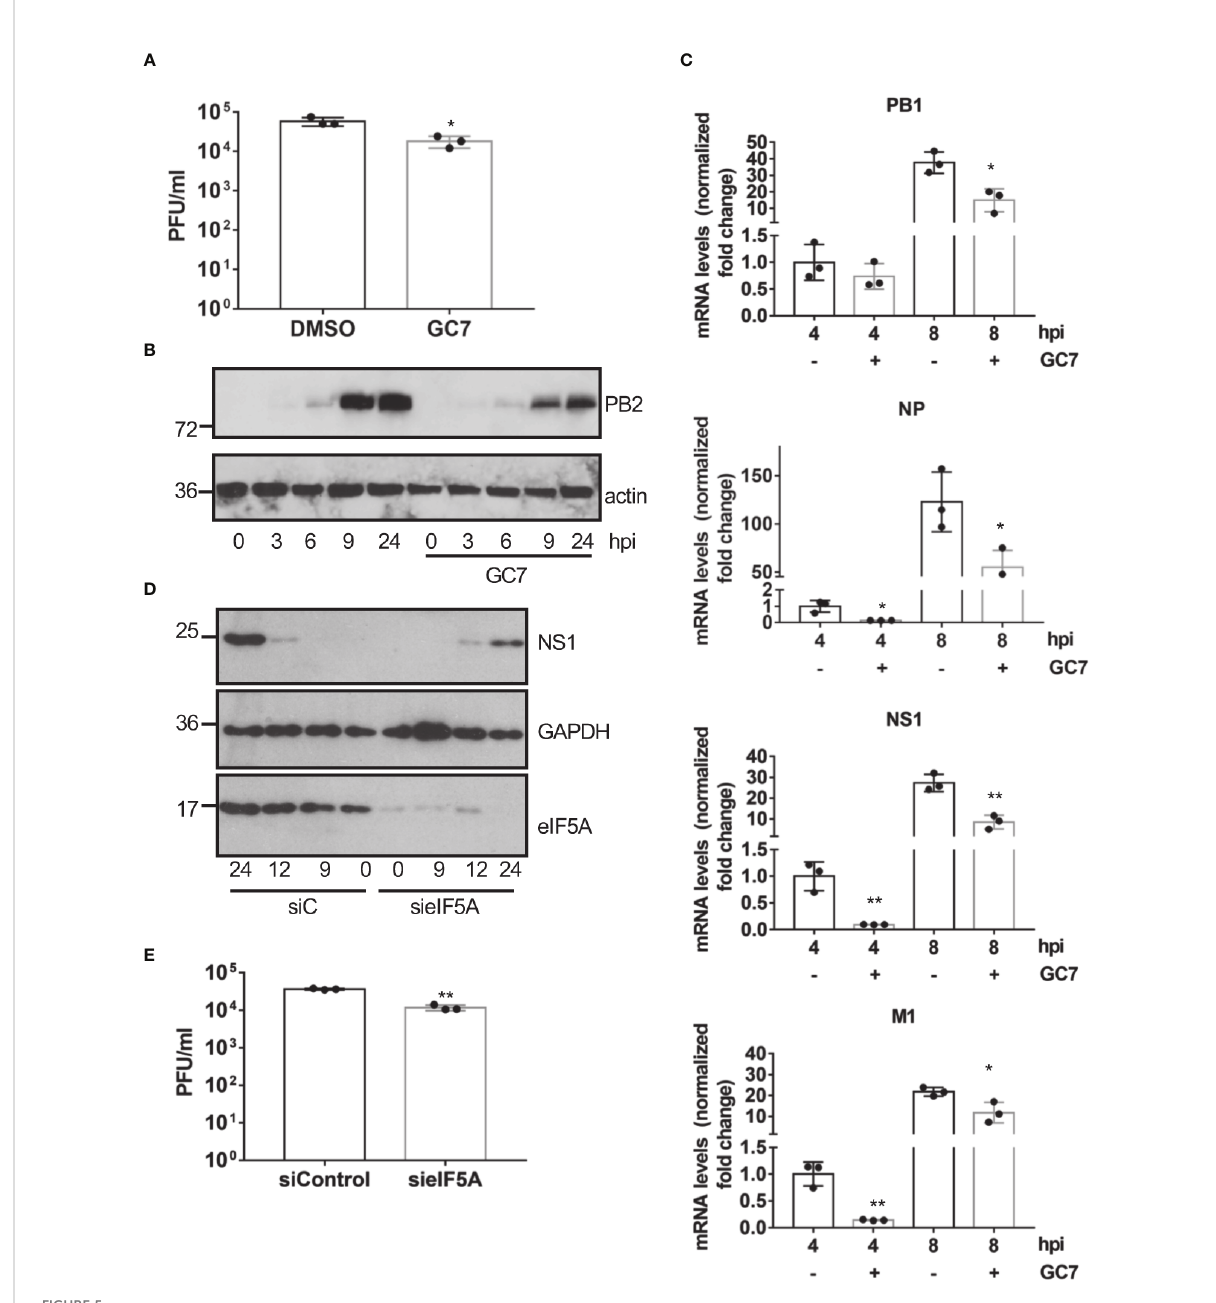
FIGURE 5 Effect of eIF5A activation on in fl uenza virus replication. (A) , Effect of hypusine inhibition on IAV virus replication. Data represent the mean and error bars of three biological replicates. Statistical analysis was assessed by a Student ’ s t-test. *, P<0.05. (B) , Consequences of GC7 treatment on IAV protein synthesis. (C) , Consequences of hypusine inhibition on viral gene transcription at the indicated times after IAV infection. Data represent the mean and error bars of three biological replicates. Statistical analysis was assessed by a Student ’ s t-test. *, P<0.05; **, P<0.005. (D) , Effect of eIF5A1 downmodulation on NS1 IAV protein expression. (E) , Effect of eIF5A1 downmodulation on IAV replication. Data represent the mean and error bars of three biological replicates. Statistical analysis was assessed by a Student ’ s t-test. **,